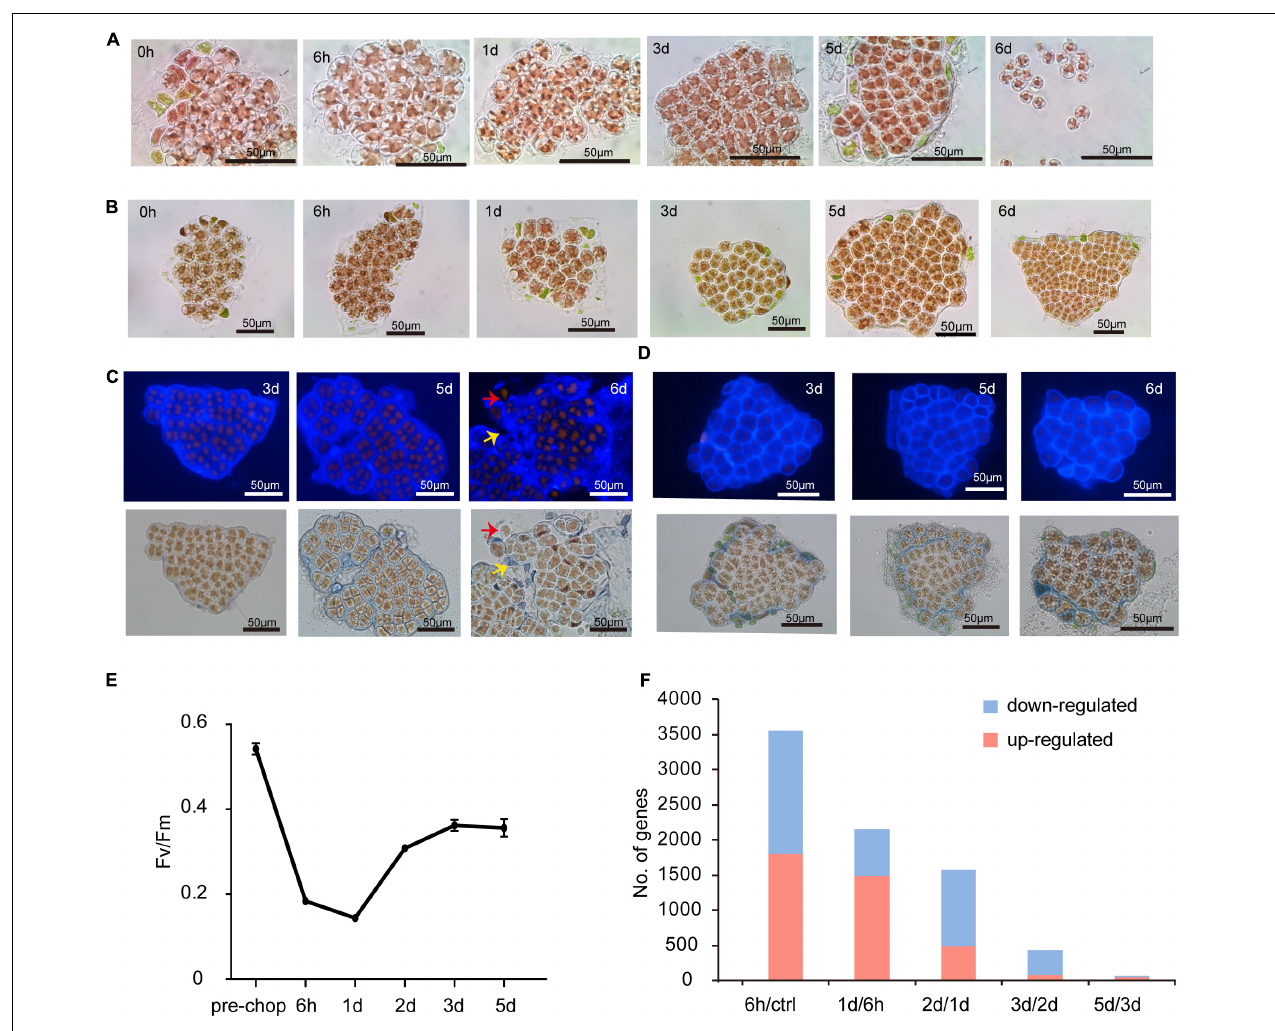
FIGURE 1 | Morphological changes of cut fragments during the wound-induced spore formation and statistics of DEGs identified in the two Pyropia spices. (A) Cellular changes in cut fragments along the time course after wounding in N. yezoensis . Time refers to the duration (in hours and days) since the onset of wounding. (B) Cellular changes in cut fragments along the time course after wounding in N. haitanensis. (C) Calcofluor white staining of cell wall changes during the formation of sporangia and release of spores in N. yezoensis . The red arrow indicates a released spore without any cell wall. The yellow arrow indicates the remaining cell wall debris and interval matrix after spores released. (D) Calcofluor white staining of cell wall changes in N. haitanensis. (E) The variation in photosynthetic efficiency of cut fragments over time in N. haitanensis . Mean values of Fv/Fm were plotted with the vertical bars representing SD ( n = 5 biological independent samples). (F) Histogram showing the number of up- and down-regulated genes at each time point compared to the previous time point in N. haitanensis